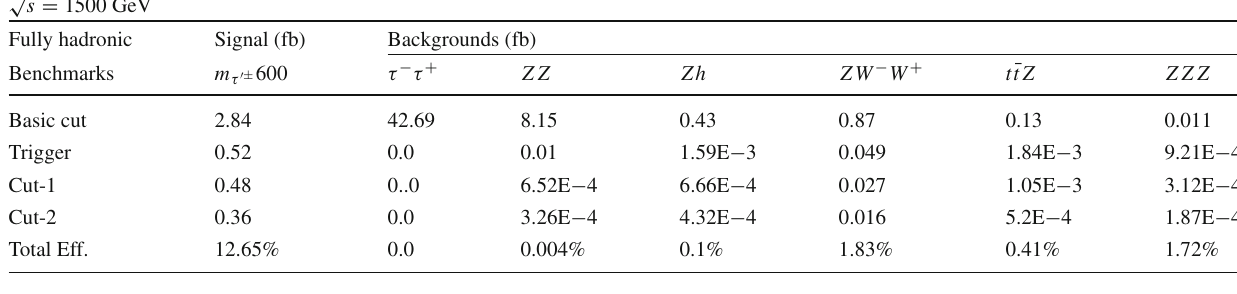
Table 11 Cut flows of the signal and backgrounds at m τ (cid:2)± = 600 GeV, √ s = 1500 GeV Fully hadronic Signal (fb)